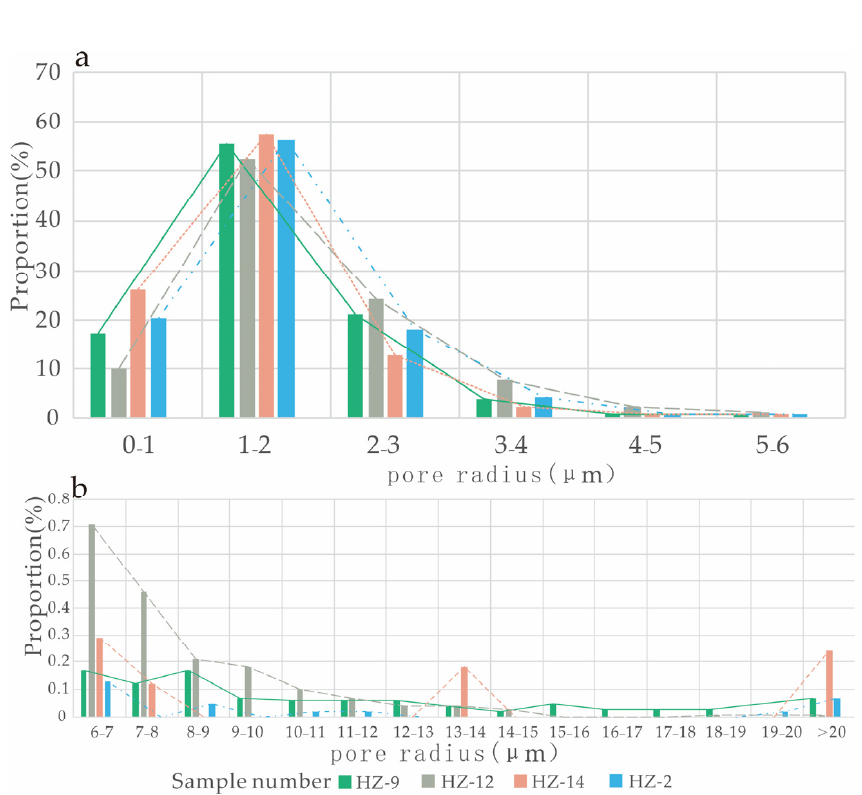
Figure 8. Pore radius ratio of the carbonate rock samples in the Huize lead–zinc deposit. ( a ) Radius 0–6 μ m Histogram of the proportion of pores to the total number of pores; ( b ) Radius 6–20 µ m and more than 20 μ m Histogram of the proportion of pores to the total number of pores